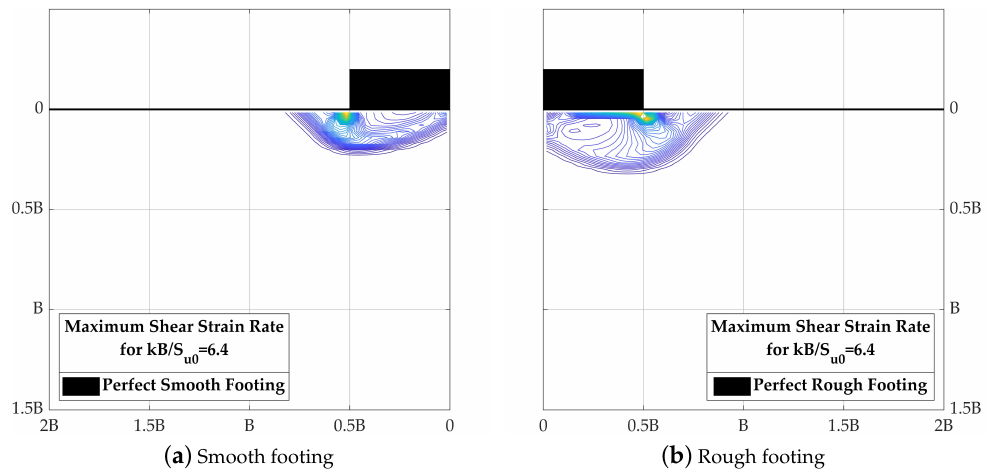
Figure 17. Maximum shear strain rate at the numerical limit load ( kB / S u 0 =